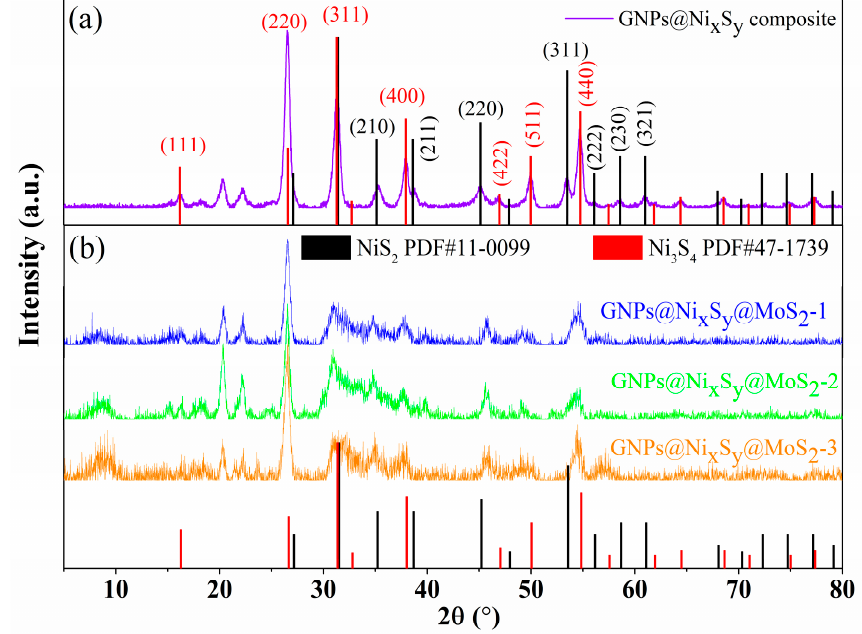
Figure 1. XRD patterns of ( a ) GNPs@Ni x S y composite, and ( b ) GNPs@Ni x S y @MoS 2 composites.